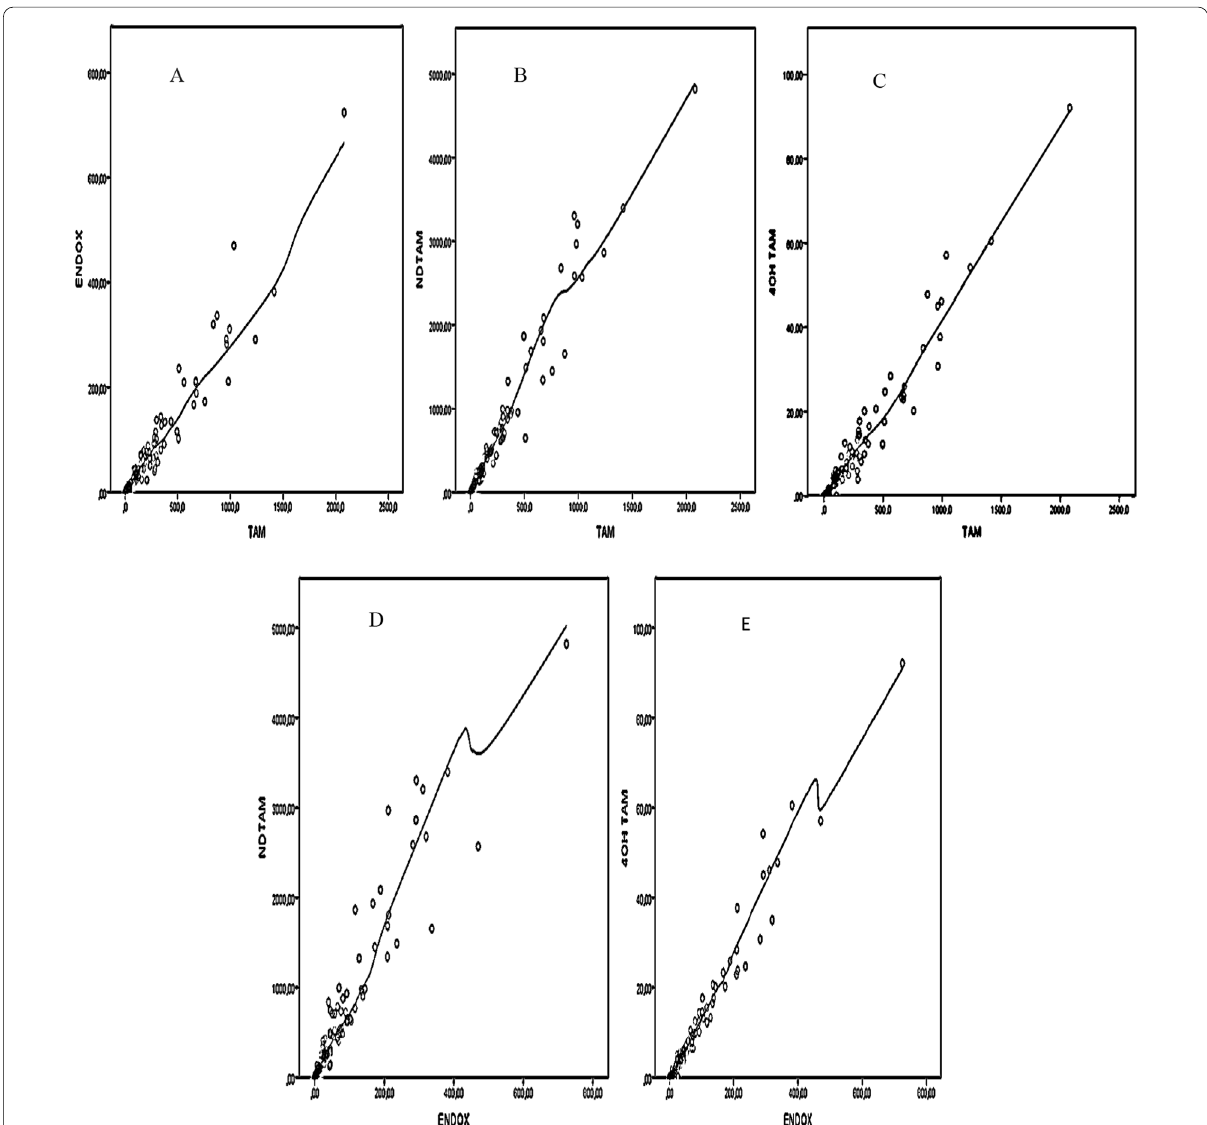
Fig. 2 Scatter plot showing the Pearson’s correlation between Endoxifen versus tamoxifen ( A ), N-desmethyltamoxifen versus Tamoxifen ( B ) and 4-hydroxytamoxifen versus Tamoxifen ( C ), Endoxifen versus N-desmethyltamoxifen ( D ) and Endoxifen versus 4-hydroxytamoxifen ( E